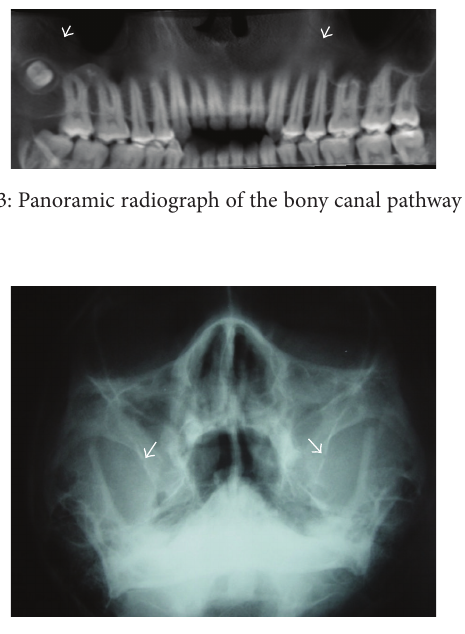
Figure4:Posteroanteriorradiographofthemaxillarysinus(Water’s projection) showing a radiolucent area corresponding to the route of the neurovascular bundle (white